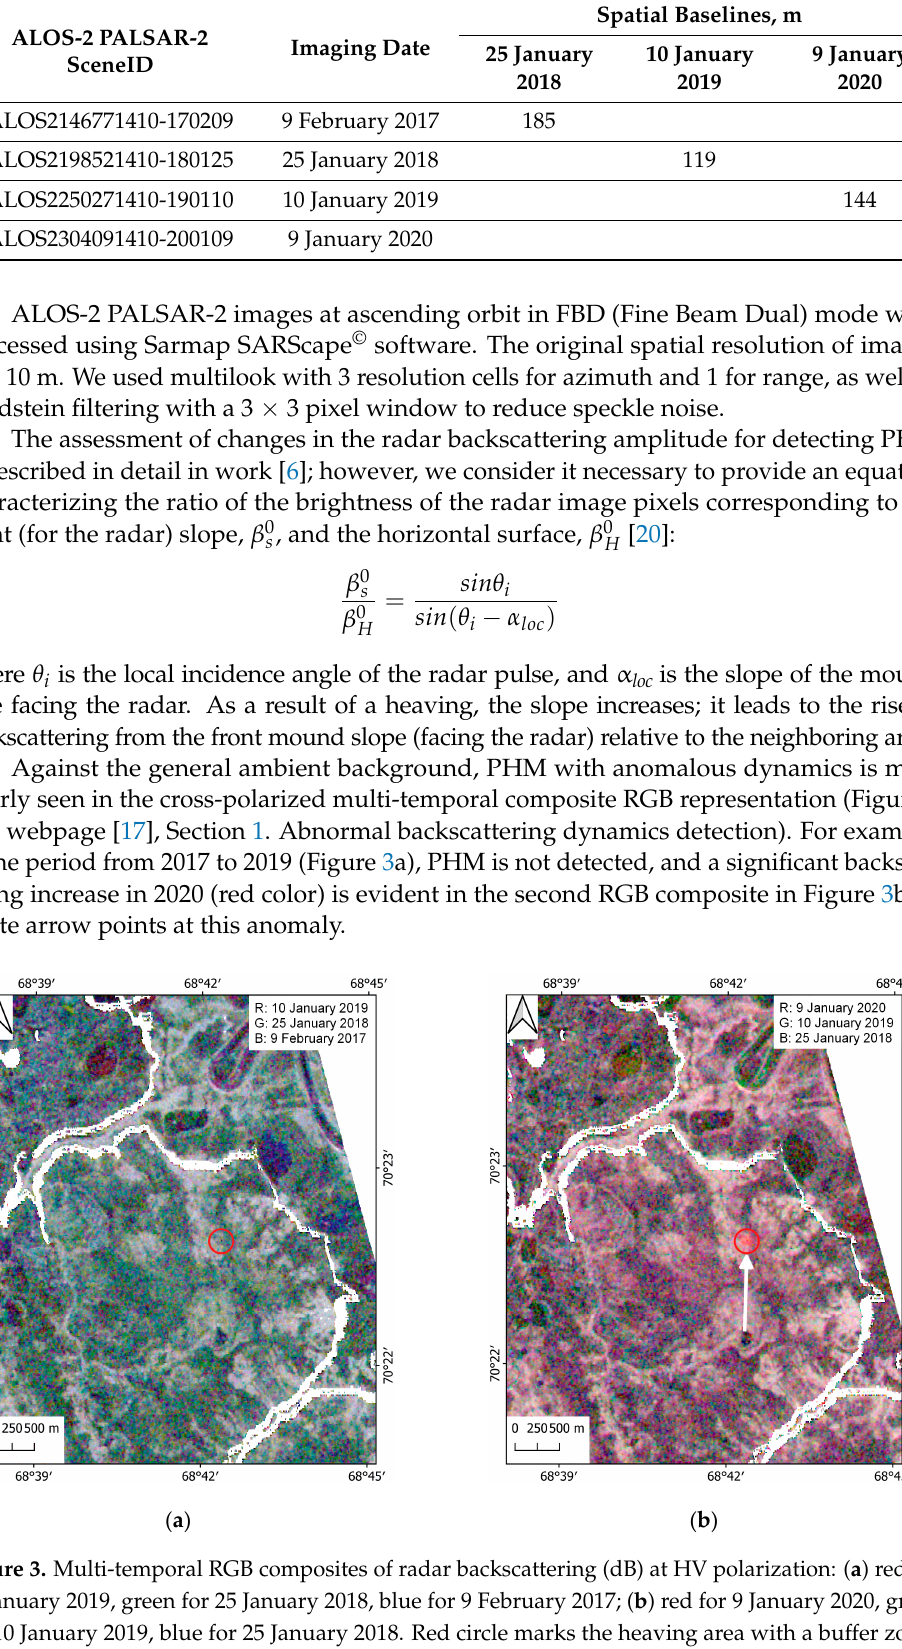
Table 1. Used ALOS-2 PALSAR-2 data.